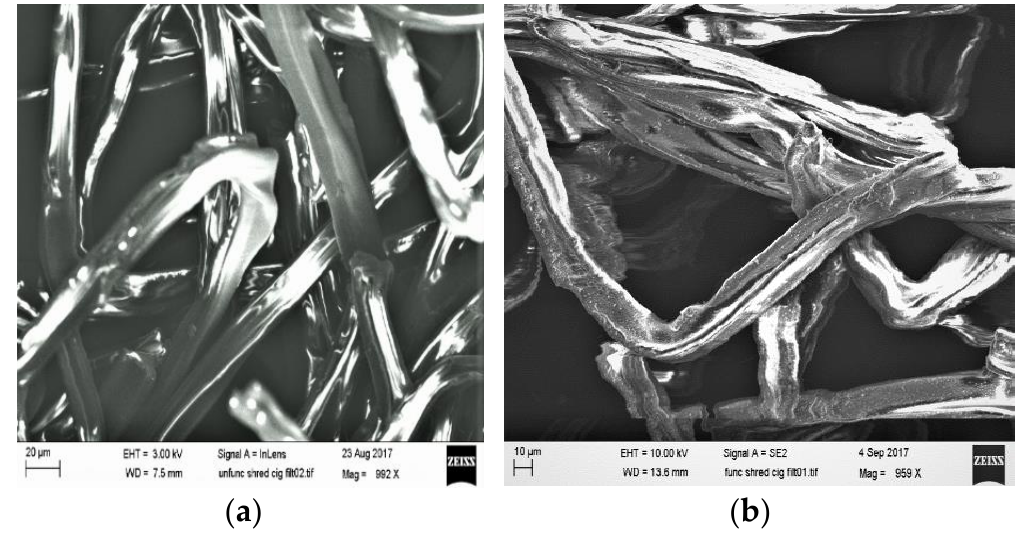
Figure 4. ( a ) Un-functionalised cigarette filter surface morphology; ( b ) functionalised cigarette filter surface morphology.